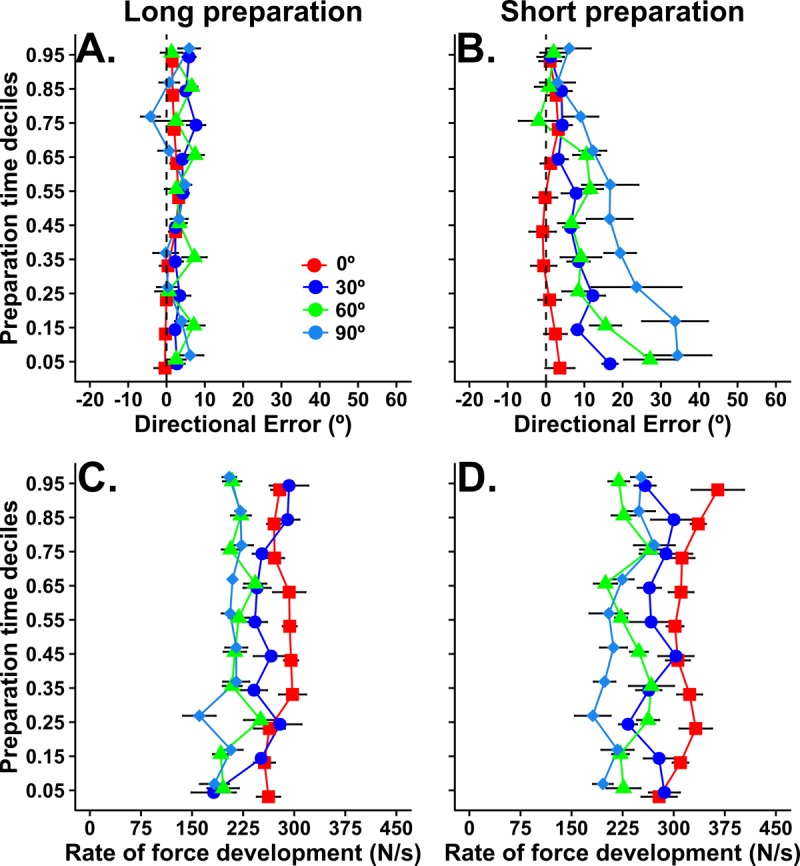
Plots showing how movement bias (top) and vigor (bottom) vary as a function of preparation time and target angle within each preparation time condition in experiment 2 (reaction time task).Group average (and within-subjects SE) values for bias and vigor are plotted for trials corresponding to each preparation time decile (as explained in Figure 3).10.7554/eLife.26713.010Figure 5—source data 1.Source data for plots in panels 5a, 5b, 5c, 5d.